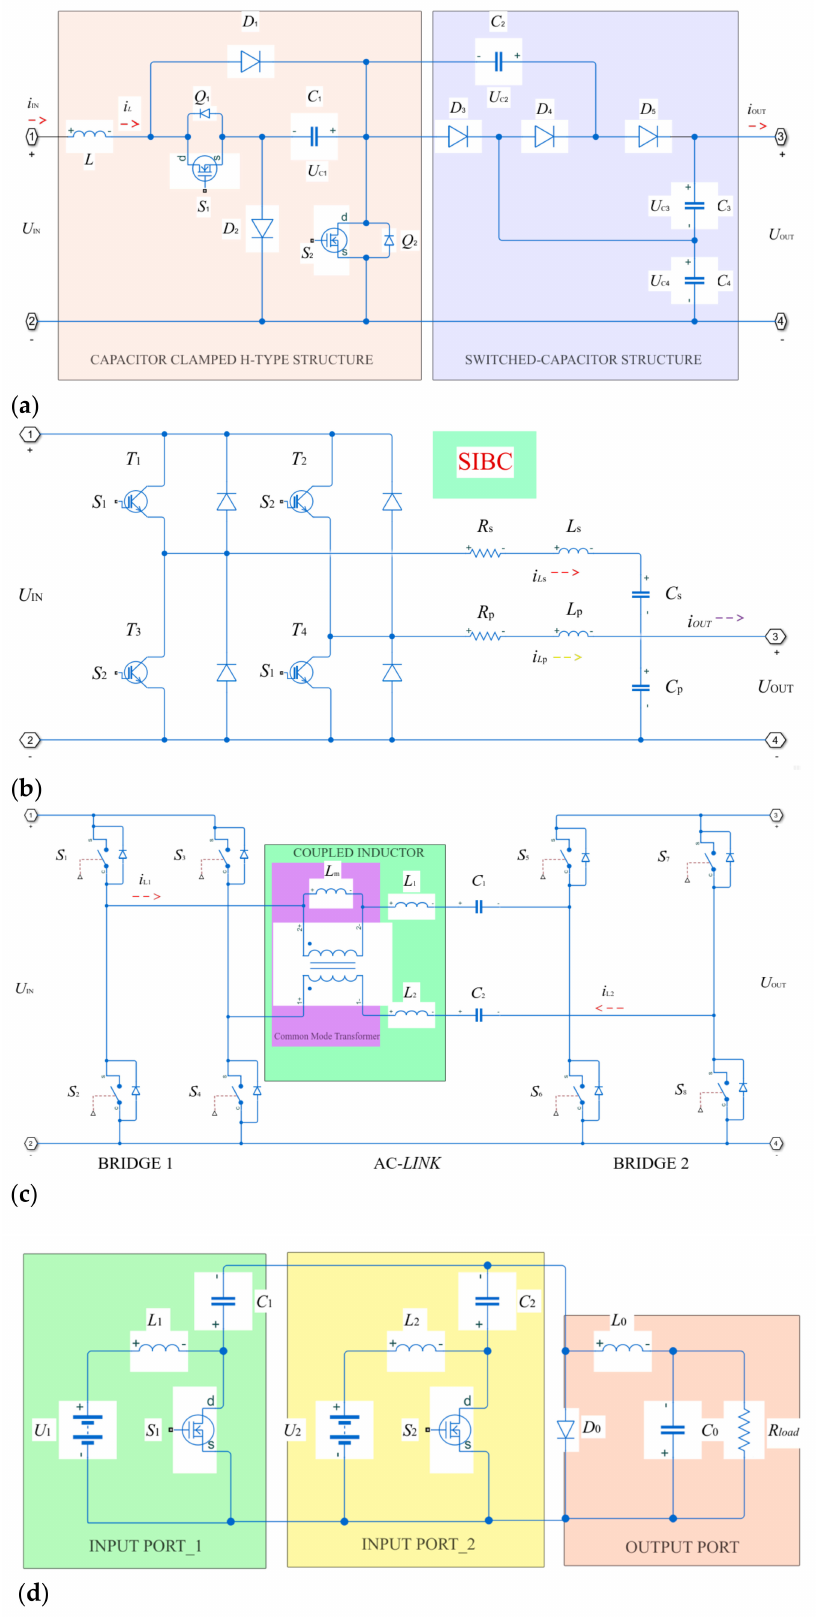
Figure 4. Typical topologies of Non-isolated DC/DC Converters. ( a ) Clamped capacitor H-type boost DC-DC converter; ( b ) Stacked interleaved DC-DC buck converter; ( c ) Magnetically coupled buck-boost bidirectional converter; ( d ) Non-isolated unidirectional three-port Cuk-Cuk